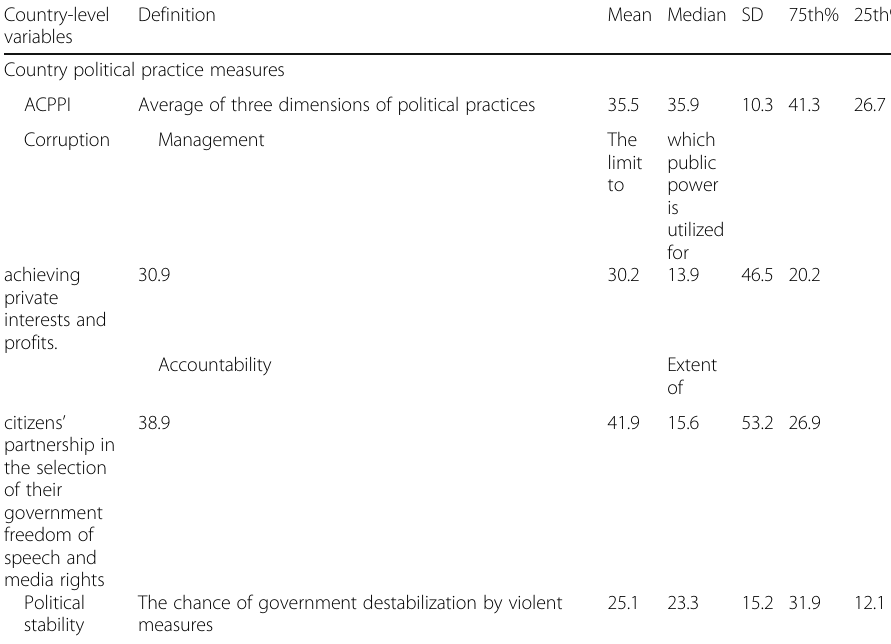
Table 3 Data Description at